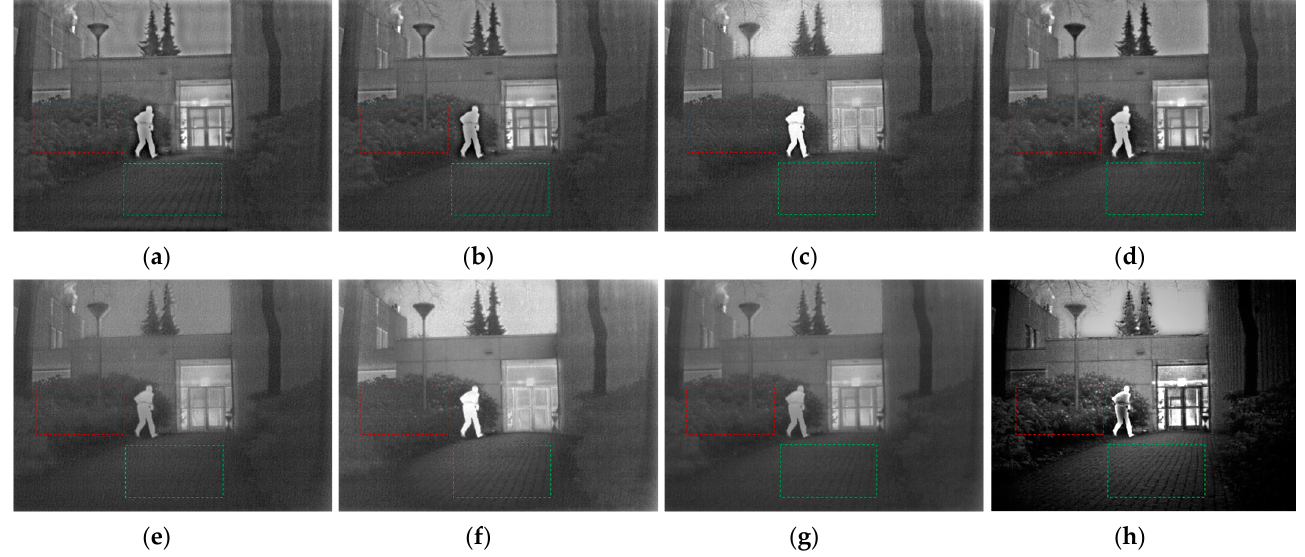
Figure 9. Performance comparison of different fusion methods on the image pair “Kaptein”. ( a – h ) are the results of CVT, CWT, WLS, LP, ADF, GTF, MSVD and our algorithm, respectively.